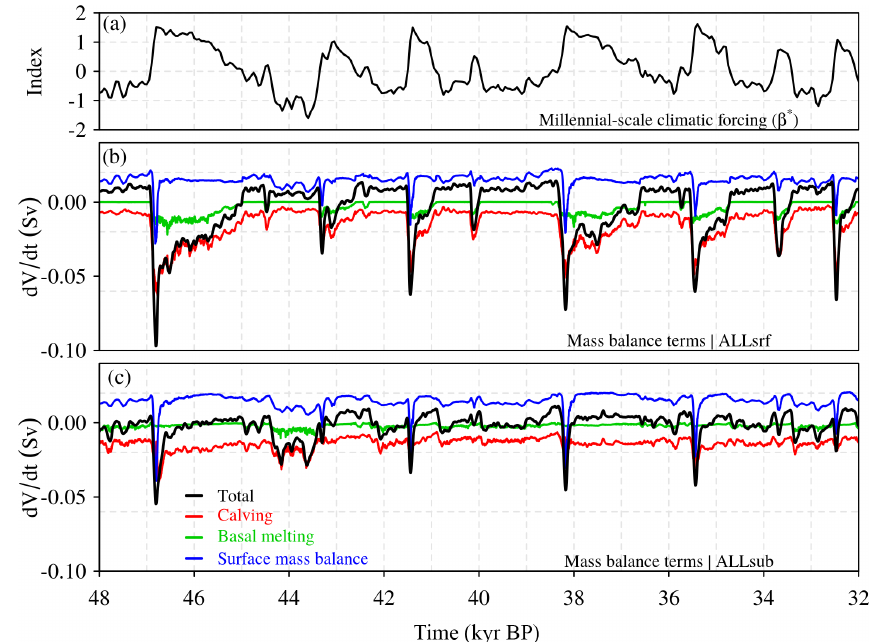
Figure 6. MIS 3 period. (a) Temporal component of the millennial-scale climatic forcing ( β (cid:63) index), and the contribution of the different terms of the EIS mass balance to ice volume variations (Sv) in the simulations considering all forcings, with (b) corresponding to the surface oceanic forcing (ALL srf ) and (c) to the subsurface oceanic forcing (ALL sub ). The calving and basal melt rates are given by the amount of ice lost to the ocean through the calving and basal melting parameterization per unit of time, converted to water-equivalent